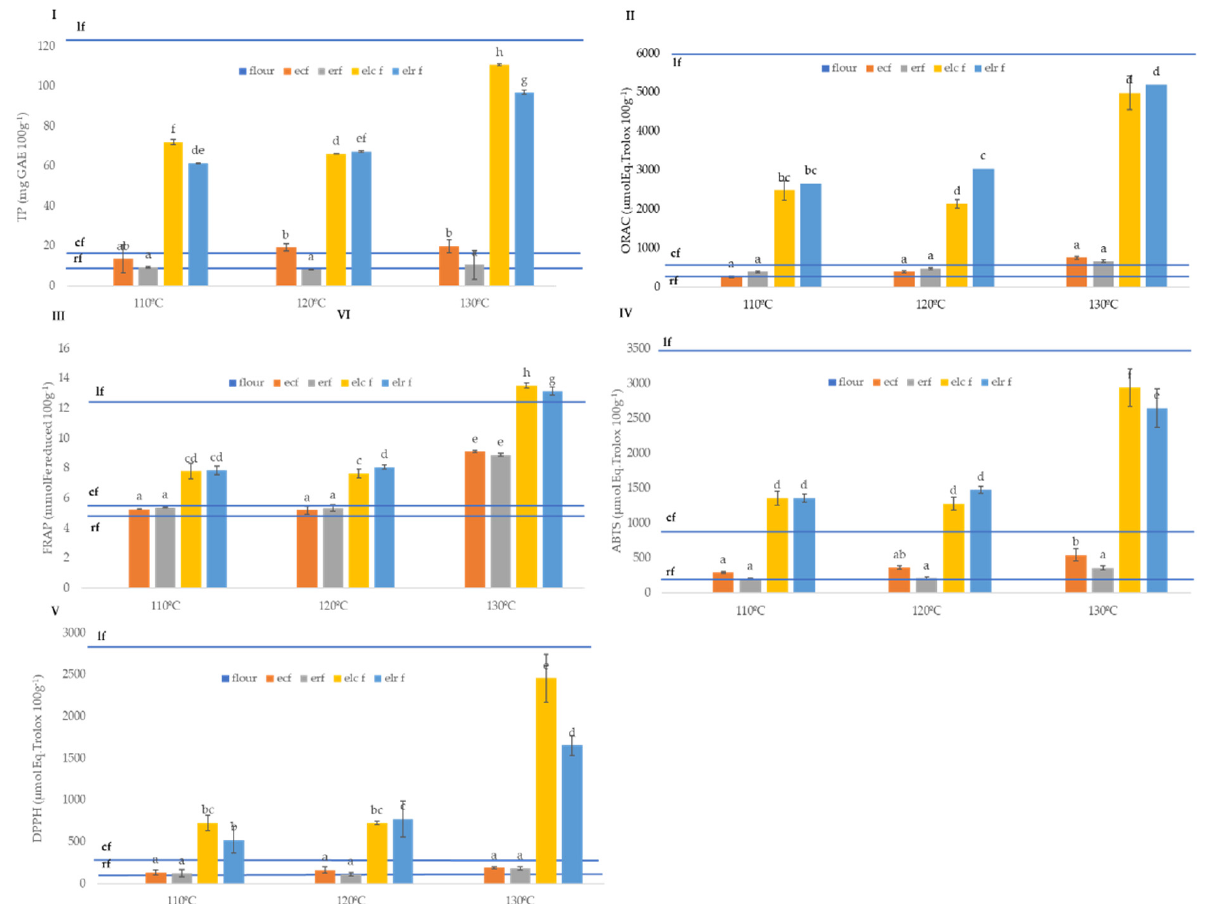
Figure 2. Total phenol (TP, mg GAE 100 g − 1 dry matter, I ), total antioxidant activity as ORAC, ABTS•+, DPPH ( II – V , µmol Eq. Trolox 100 g − 1 dry matter), and FRAP (mmol Fe 2+ 100 g − 1 dry matter) of native and extruded flours. Abbreviations: cf: corn flour; rf: rice flour; lf: lentil flour; ecf: extruded corn flour; erf: extruded rice flour; elcf: extruded lentil (50%)-corn flour; elrf: extruded lentil (50%)-rice flour. Different small letters indicate differences ( p ≤ 0.05) between samples.